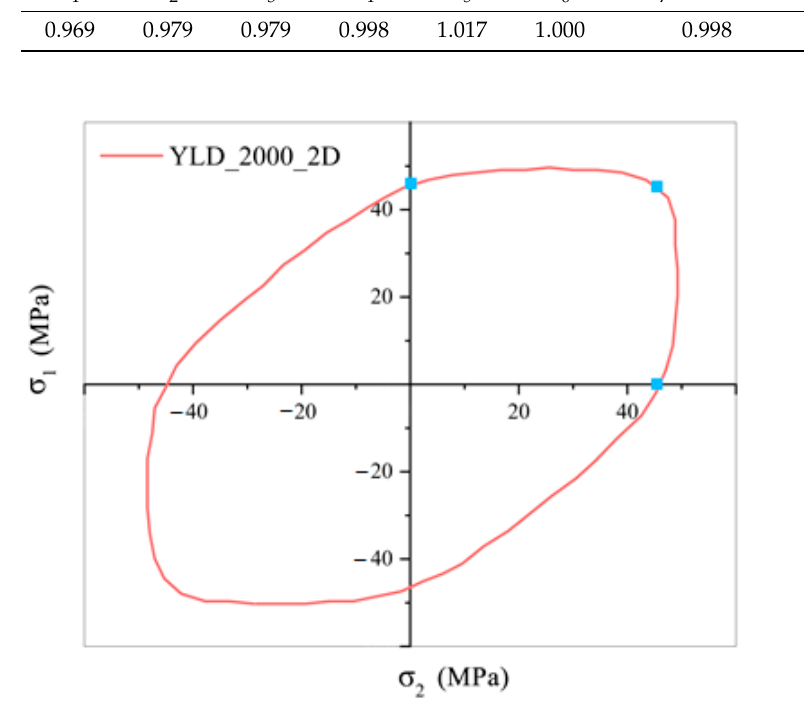
Figure 4. YLD2000-2d yield trajectory of 7075 aluminum alloy.